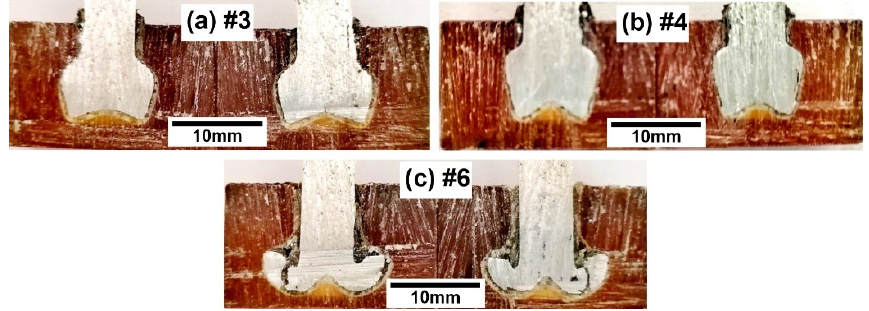
Figure 3. Macrostructural observations of the rivets obtained with different friction riveting parameters; ( a ) parameters No. #3, ( b ) parameters No. #4 and ( c ) parameters No. #6.